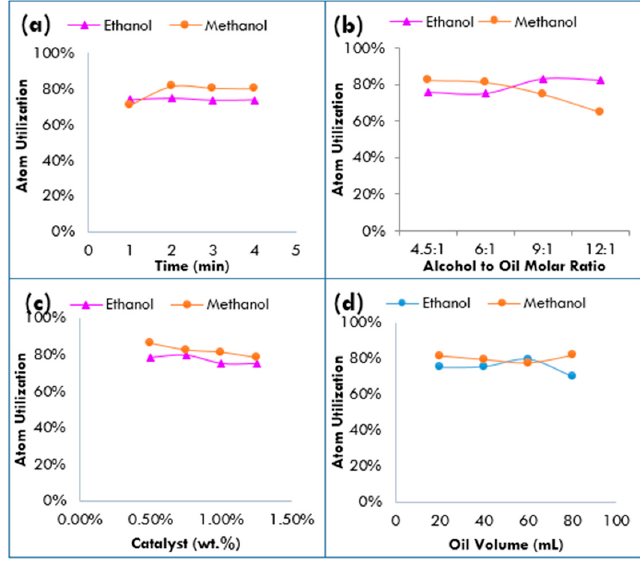
Figure 8. Atom utilization for the simultaneous effect of MW/US in WCO transesterification. Effect of ( a ) different reaction time; ( b ) alcohol to oil molar ratio; ( c ) catalyst concentration and ( d ) sample (oil) volume.